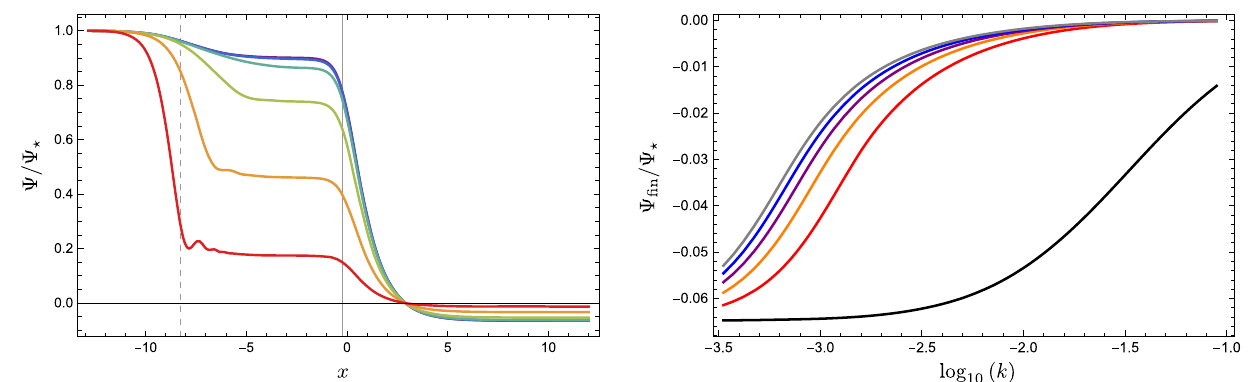
for different colours are the same as those used in Fig. 3. The right panel shows the asymptotic value of the gravitational potential in terms of log ( k ) for five different values of the effective speed of sound param- = 0 (black), c 2 = 0 . 2 (red), c 2 = 0 . 4 (orange), c 2 = 0 . 6 eter: c 2 s d s d s d s d = 0 . 8 (blue) and c 2 = 1 (purple), c 2 s d s d